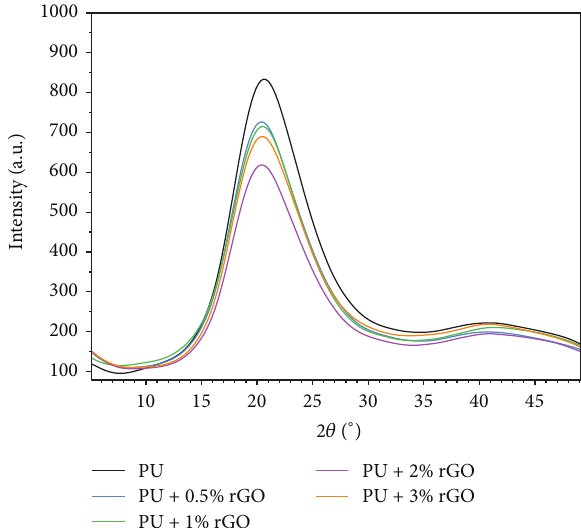
Figure 7: XRD spectra of PU